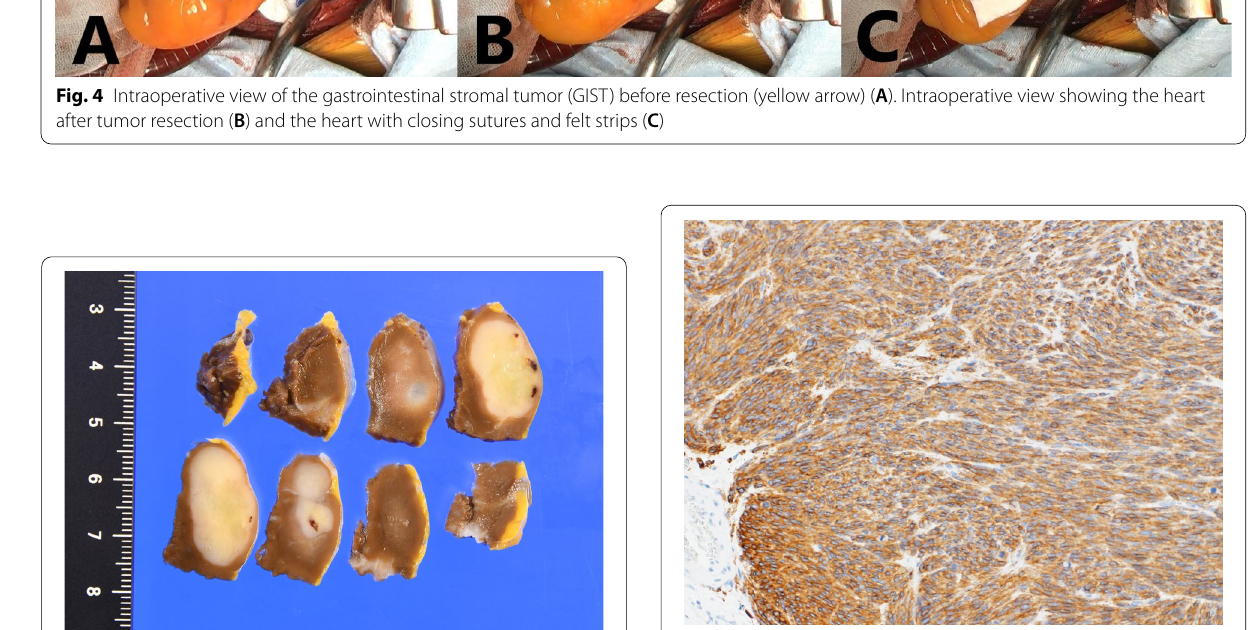
Fig. 7 Positive immunostaining for c-KIT (CD117) (magnification 100) indicated a gastrointestinal stromal tumor (GIST) ×